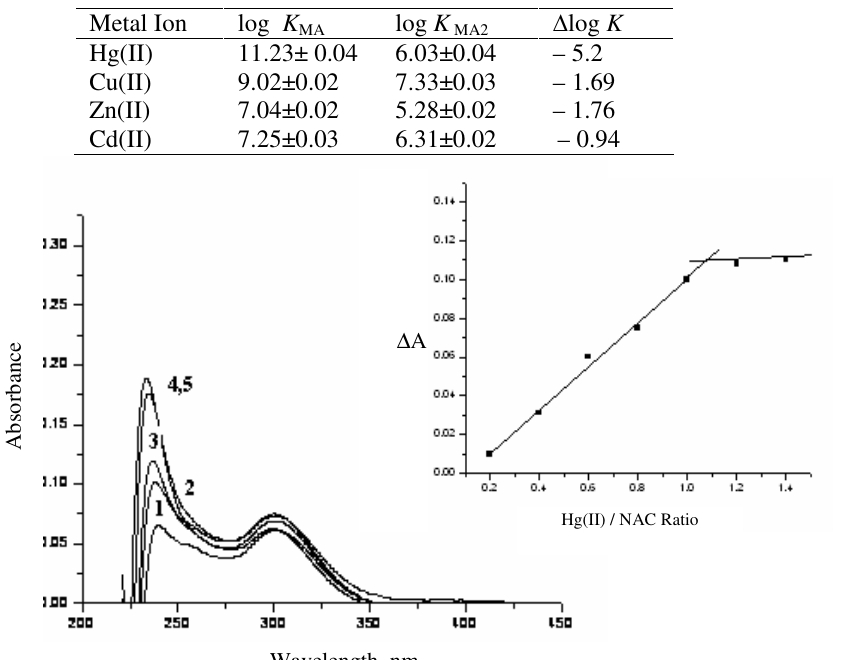
Table 3 . Stability constants of N -acetylcysteine (A), Metal(II) 1:1 and 1:2 binary complexes at 25 °C and I=0.1 mol dm -3 KNO